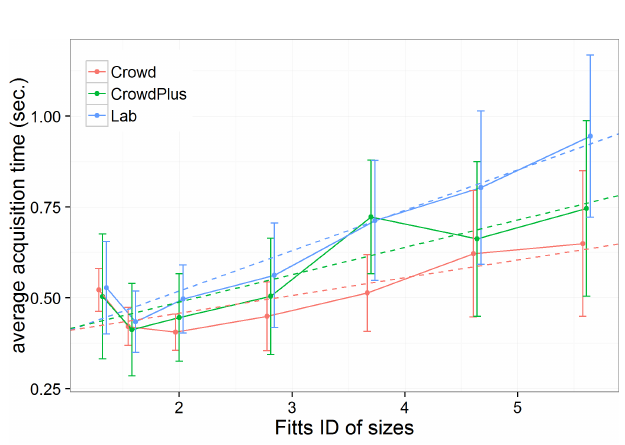
Figure 8. Average acquisition time by size (in Fitts’ ID) including 0.95 confidence interval error bars for the three filtered groups